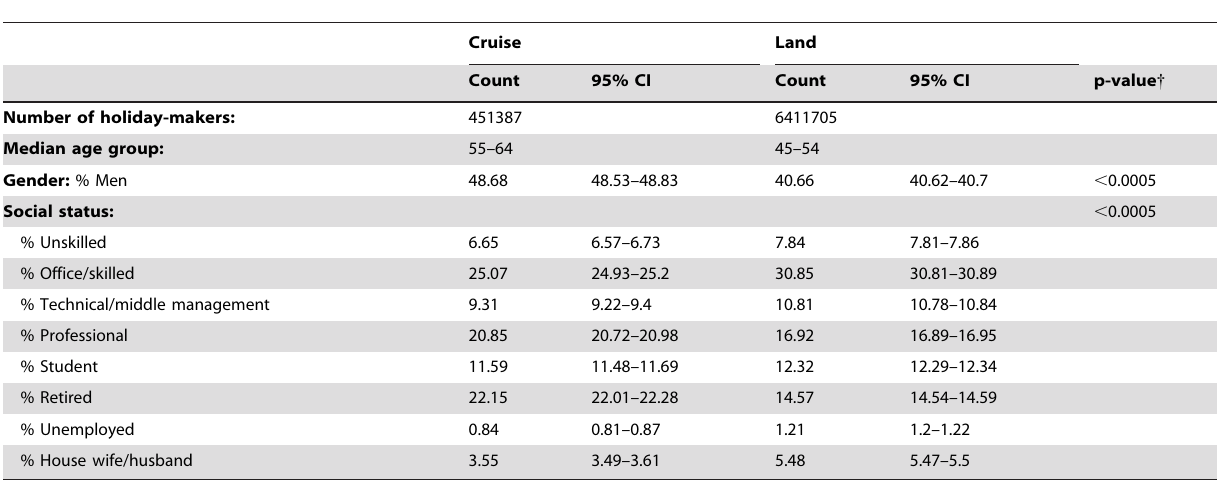
Table 1. Demographic details of travellers on cruise- and land-based holidays.